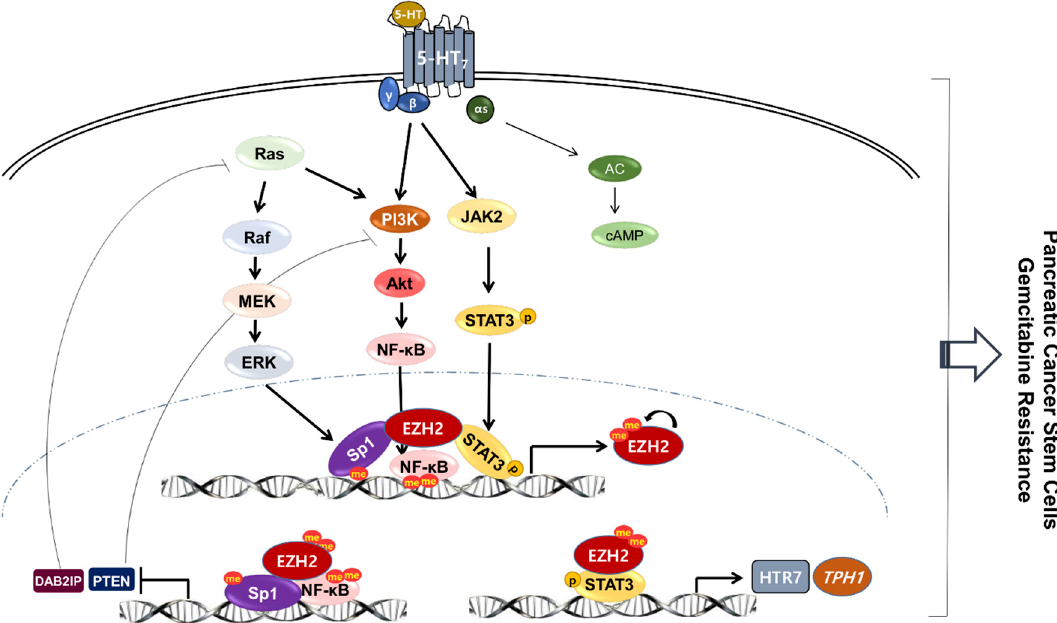
Figure 8. Schematic summary of noncanonical permissive action of EZH2 on TPH1-5-HT 7 expression in PDAC. 5-HT activates PI3K/Akt and JAK2/STAT3 through G βγ linked to 5-HT 7 . Together with Ras-activated ERK signaling, these signaling pathways enhance the nuclear level of Sp1, NF- κ B, and p-STAT3, leading to EZH2 upregulation. Under the permissive action of EZH2, p-STAT3 is required for upregulation of TPH1 and 5-HT 7 , whereas Sp1 and NF- κ B contribute to transcriptional repression of DAB2IP and PTEN. Through its noncanonical action, EZH2 activates intracellular signaling pathways through two ways, (1) activation of PI3K/Akt and JAK2/STAT3 through transactivation of TPH1-5-HT 7 expressions, and (2) maintenance of the PI3K/Akt activity by inhibition of its inhibitory signals through downregulation of DAB2IP and PTEN.